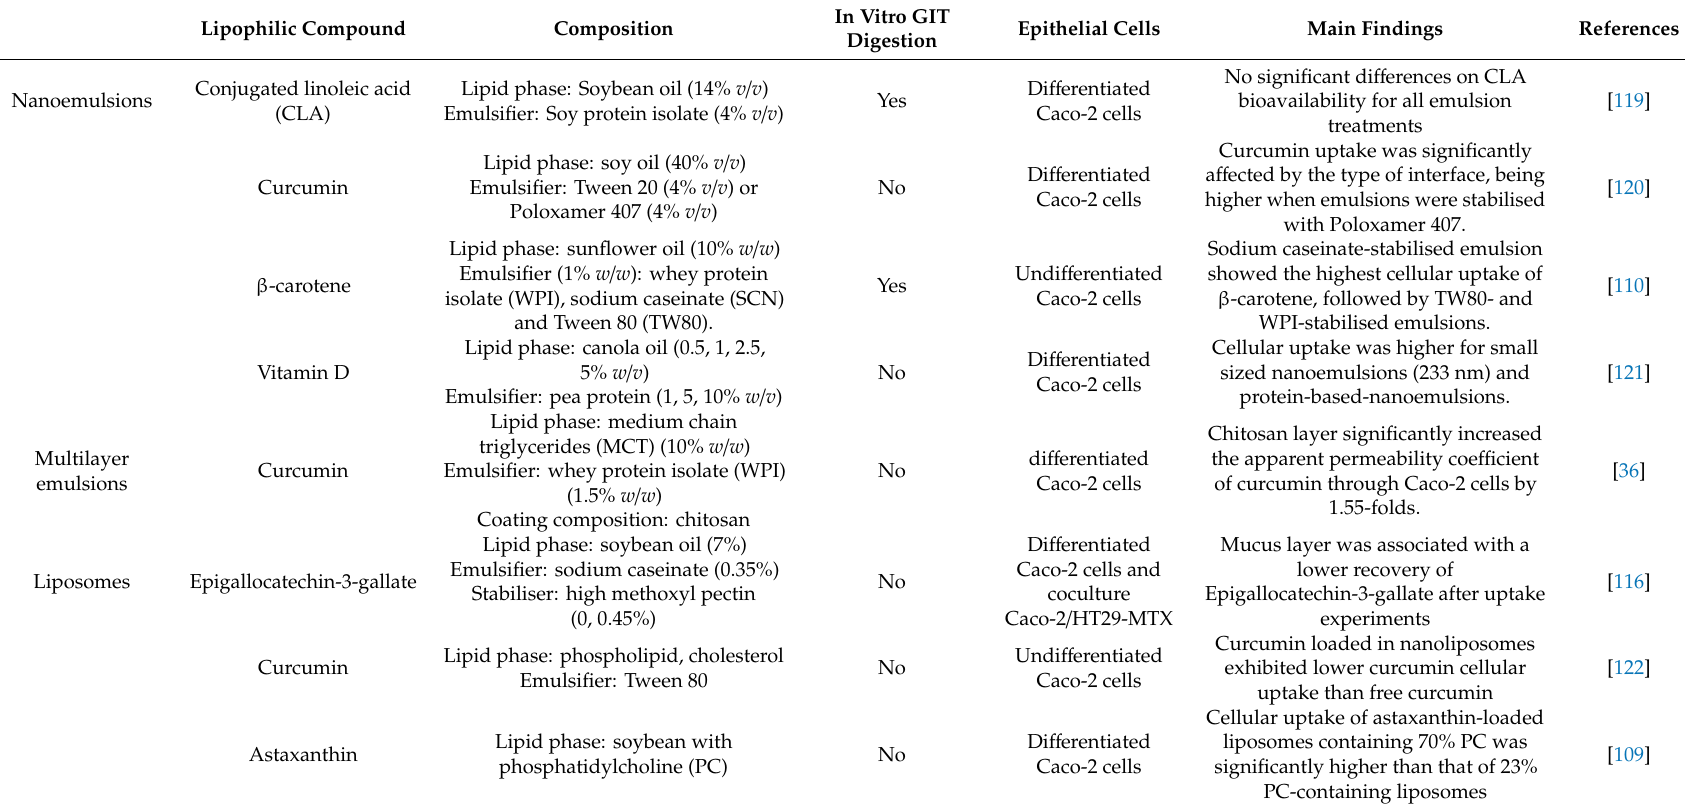
Table 3. Recent in vitro studies about di ff erent nanostructured lipid-based delivery systems encapsulating lipophilic bioactive compounds in epithelial